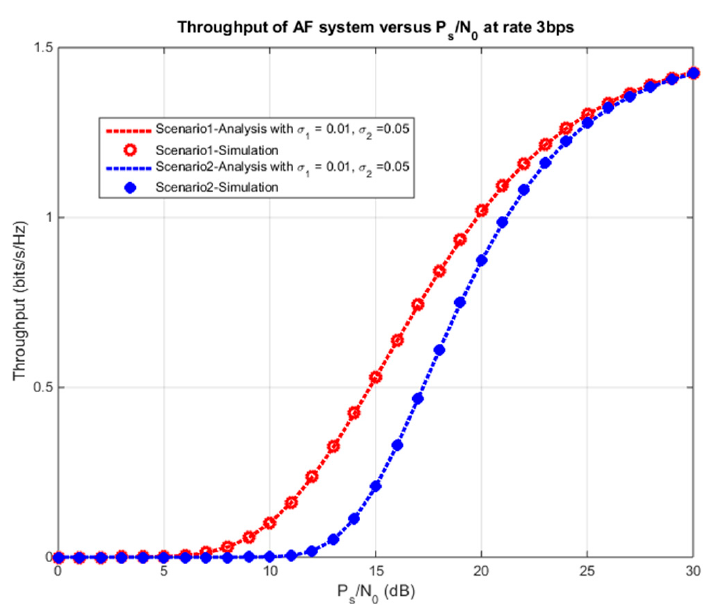
Figure 5. The outage probability versus ratio of P s / N 0 .